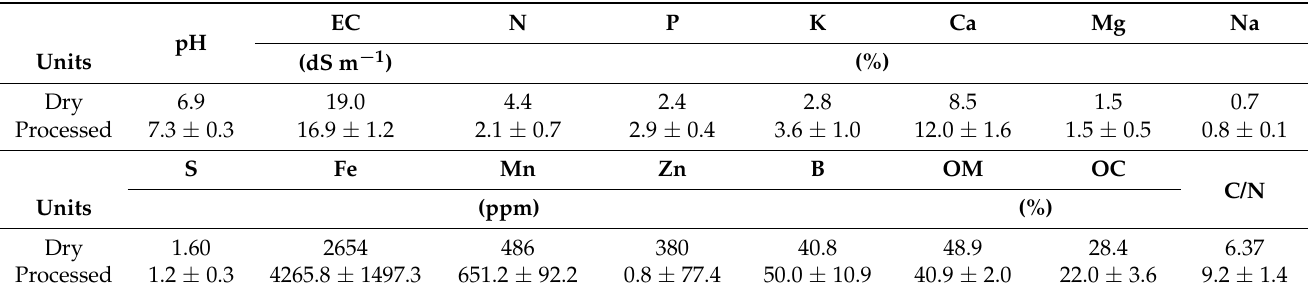
Table 5. Chemical composition of poultry manure.